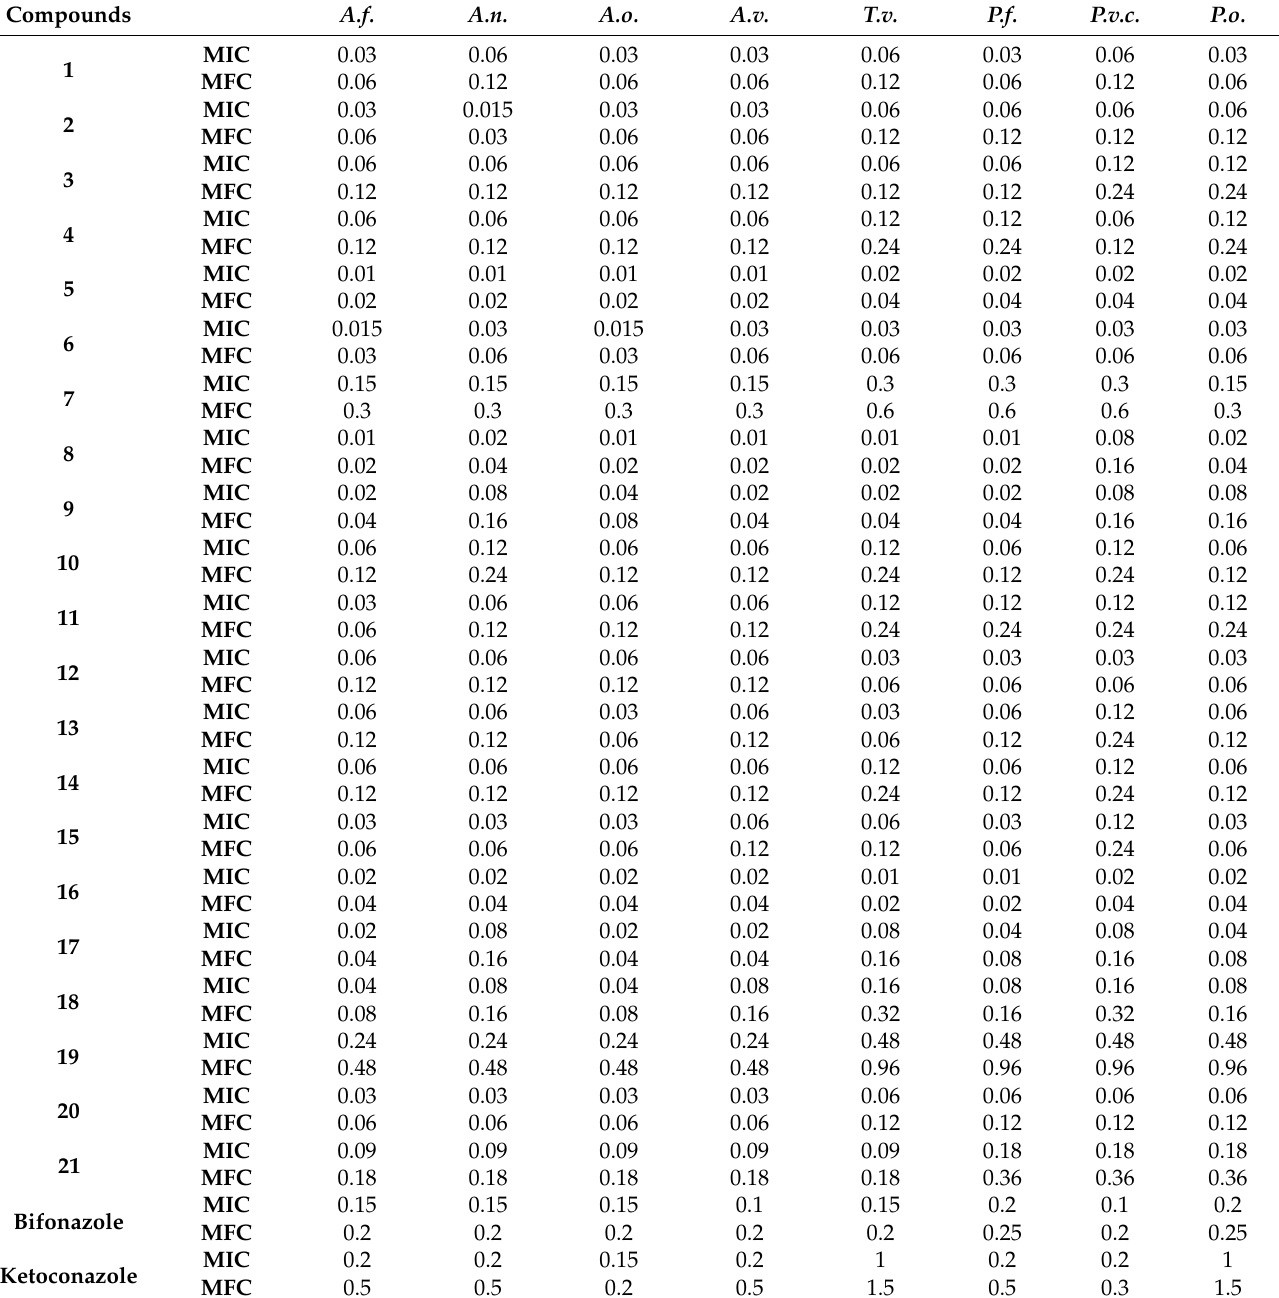
Table 4. Antifungal activity of titled compounds (MIC/MFC in mg/mL).